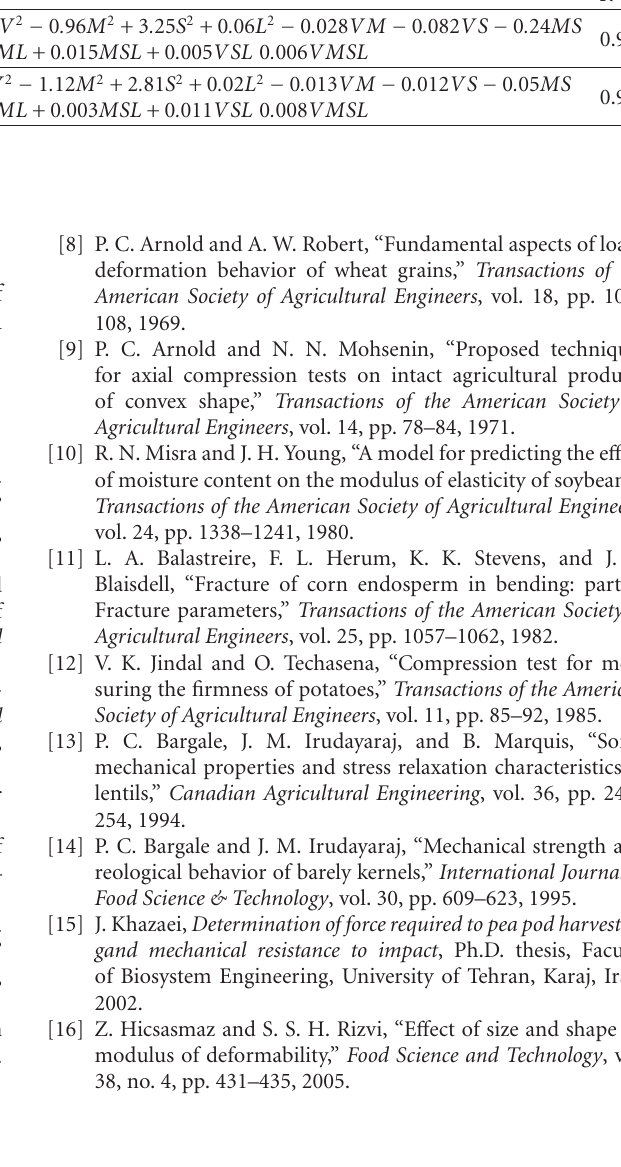
Seed Kernel Seed Kernel Seed Kernel Seed Kernel Zaria